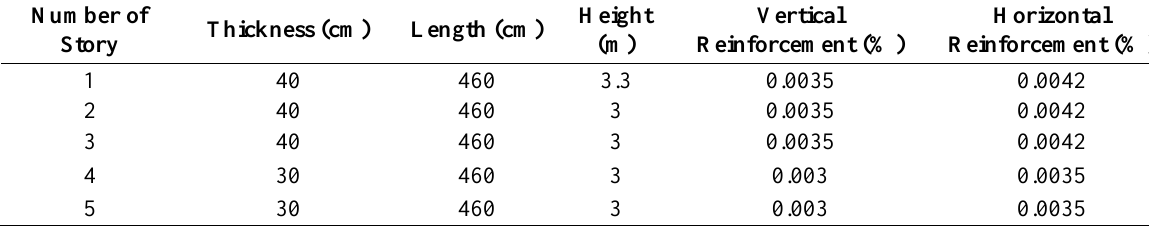
Fig. 2. Plan of 5, 10 and 15 story models (all dimensions in meters) Table 1. Geometrical specifications of the shear walls for 5-story